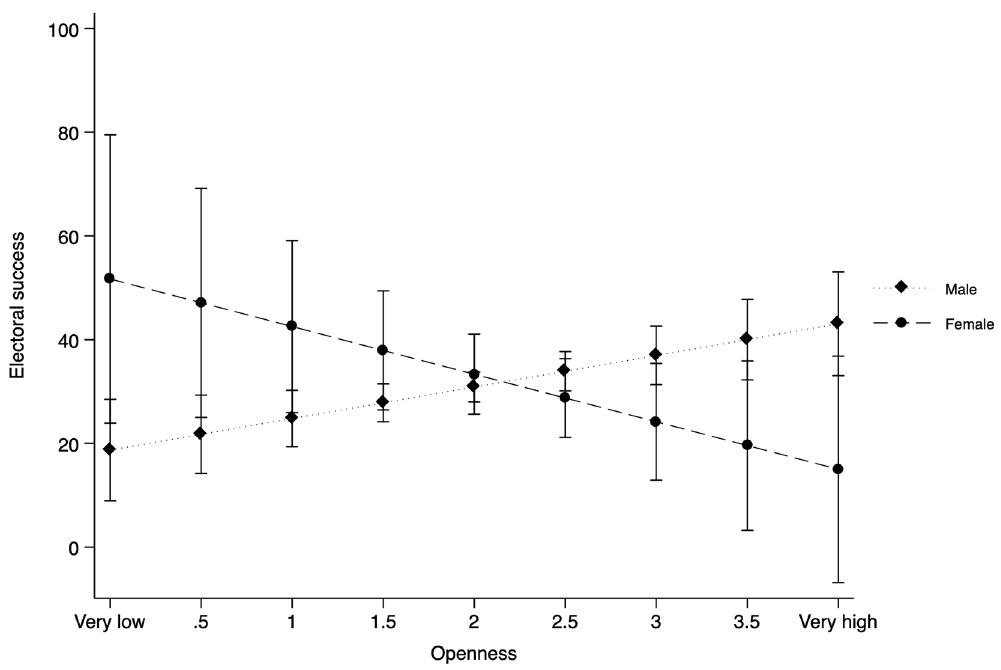
Figure 6. Electoral success by gender * Openness; marginal effects. Note. Marginal effects with 95% CI, based on coefficients in Table 5 (model M3). All other variables fixed at their